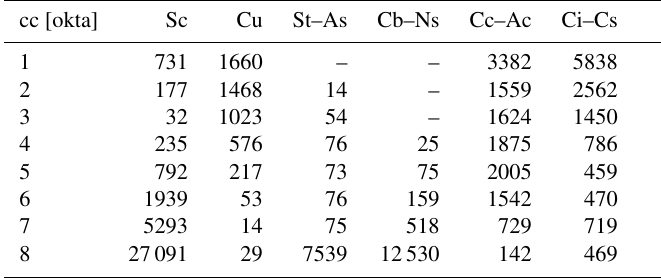
Table A2. Number of cases per okta for Payerne and